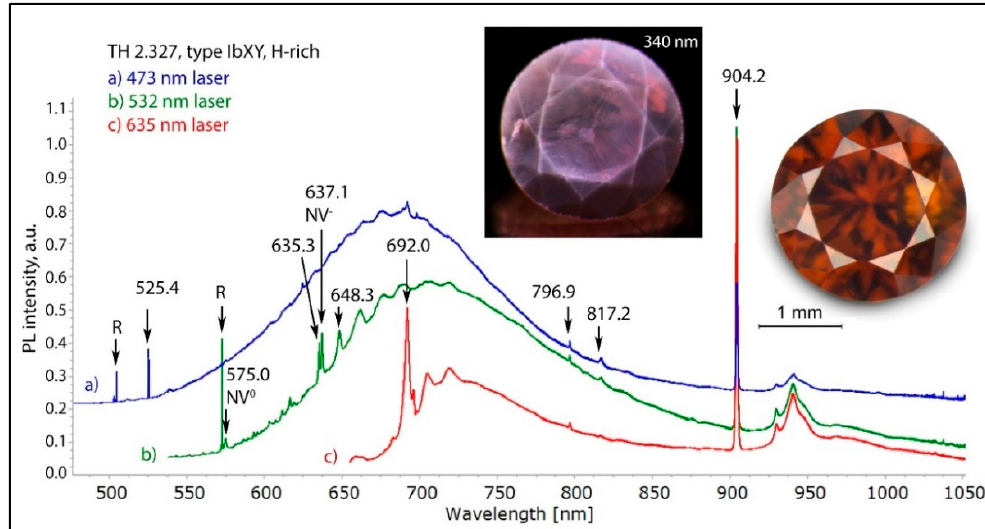
Figure 25. The photoluminescence spectra of a NDR hydrogen-rich deep brown orange type IbXY diamond of mixed cuboid octahedral growth (TH 2.327) recorded with three different lasers. The 693 nm and particularly the 904.2 nm features are very characteristic for such diamonds. The spectra have been shifted vertically for clarity. Photos: Gianna Pamies and Dr. Thomas Hainschwang.